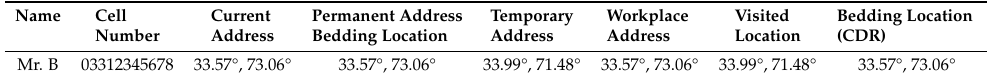
Table 5. Information gathered from the proposed